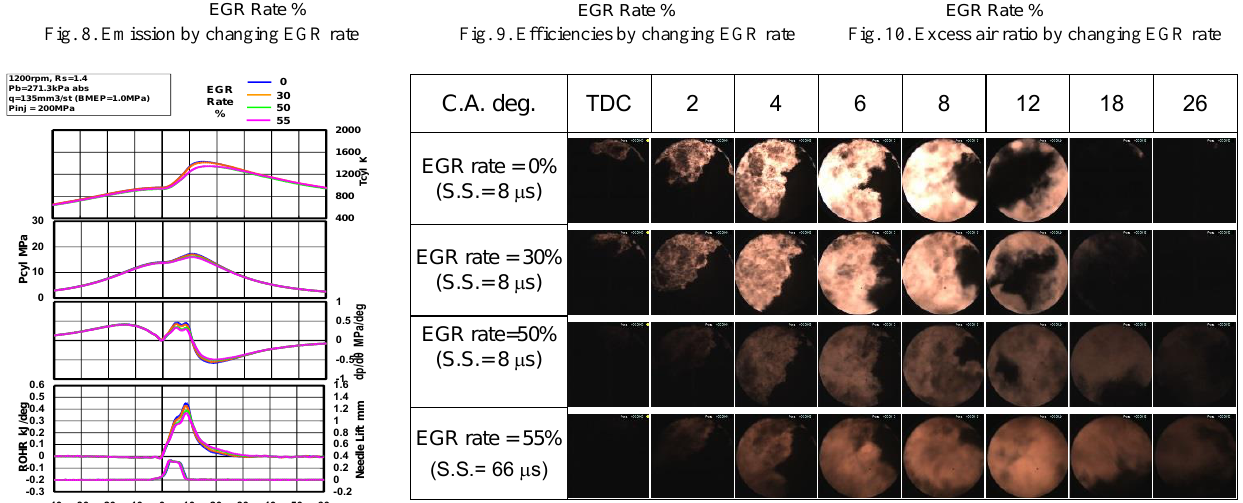
Fig. 8. Emission by changing EGR rate Fig. 9. Efficiencies by changing EGR rate Fig. 10. Excess air ratio by changing EGR rate